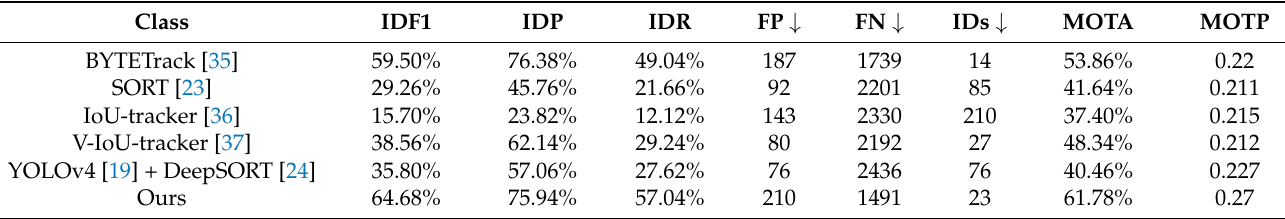
Table 3. Comparison with the same few-shot detector and